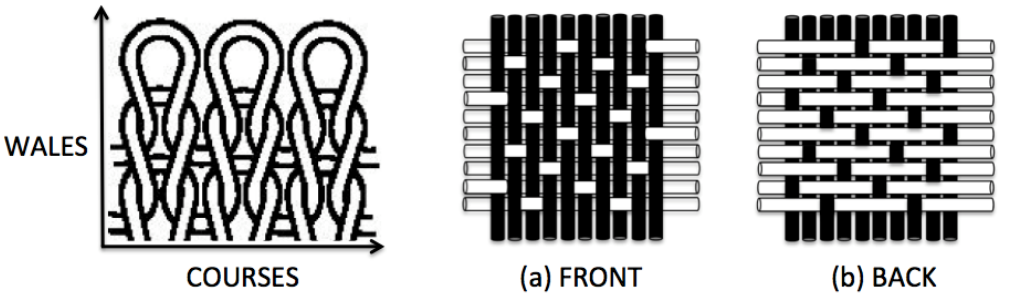
Figure 1. Schemes of: (left) Jersey knit; (middle and right) satin 5 woven; (a) front and (b)